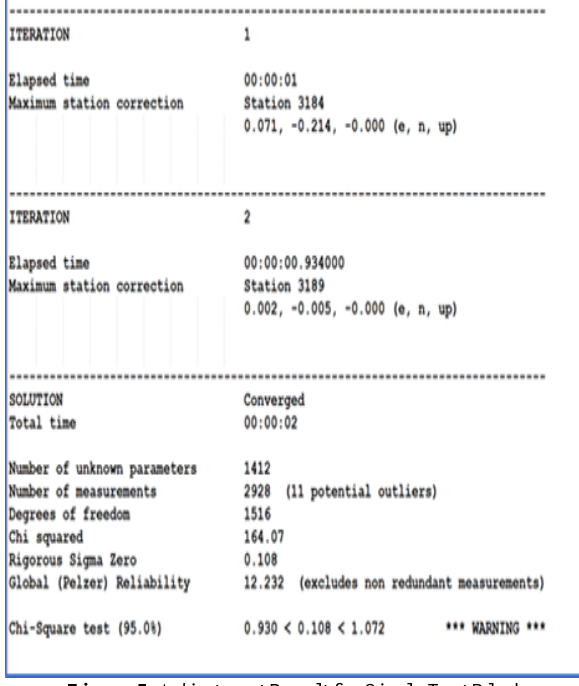
Figure 5. Adjustment Result for Single Test Block (Generated by System)